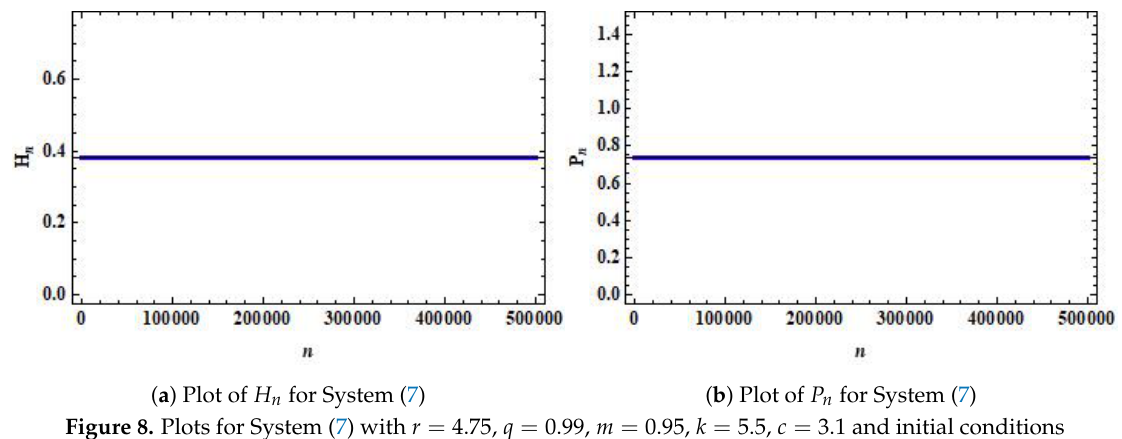
Figure 8. Plots for System (7) with r = 4.75, q = 0.99, m = 0.95, k = 5.5, c = 3.1 and initial conditions ( H ) = ( 8 × 10 10 , 5 × 10 10 ) 0 , P 0